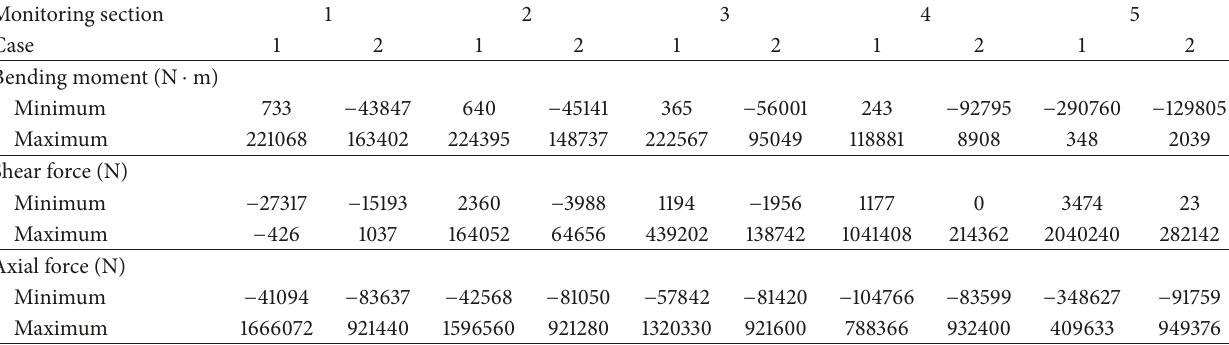
Table 4: Internal forces of the structure for monitoring sections 1–5.